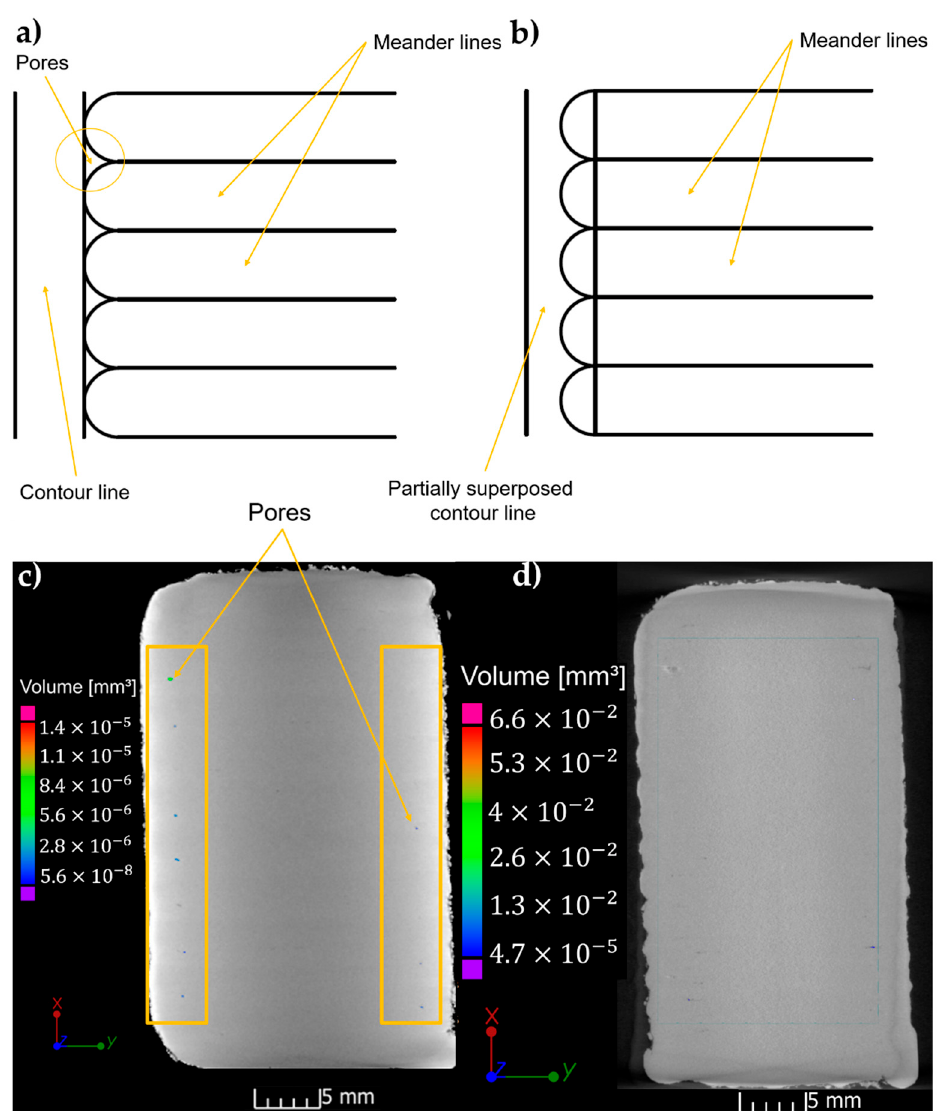
Figure 8. Schematic representation of scanning strategy with offset between contour and meander ( a ) and the corresponding XCT micrograph ( b ), schematic representation of scanning strategy with overlap between contour and meander ( c ) and the corresponding XCT micrograph ( d ).